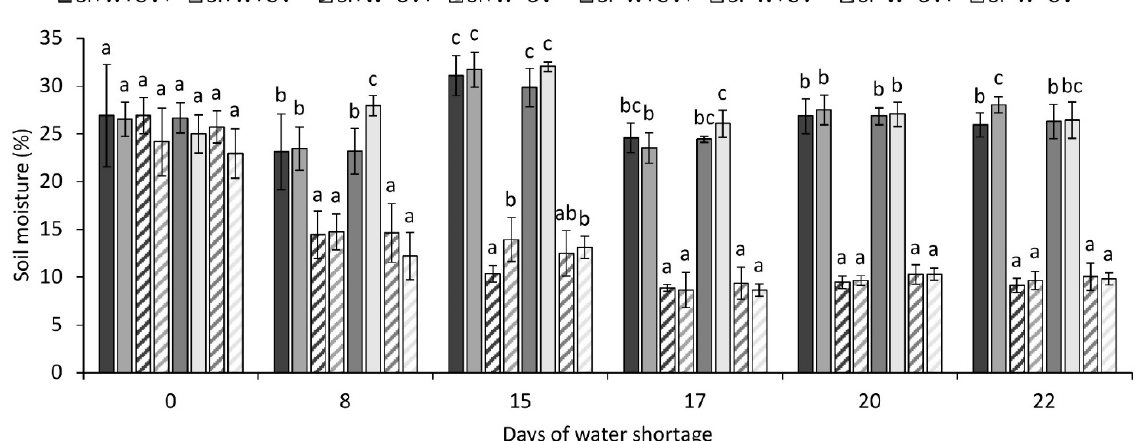
Figure 1. Soil moisture before (day 0/day 2 of K 2 SiO 3 treatment; n = 5) and during water shortage (days 8, 15, 17, 20, and 22 of water shortage; n = 25) for the eight treatments for cucumber plants. Different letters indicate significant differences between the treatments for each measurement day separately.